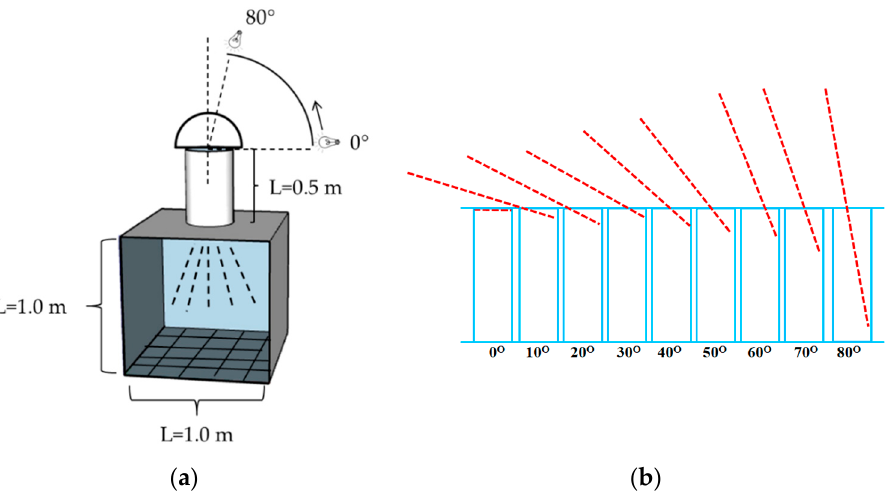
Figure 1. ( a ) View of the testing room. ( b ) Incident angle.